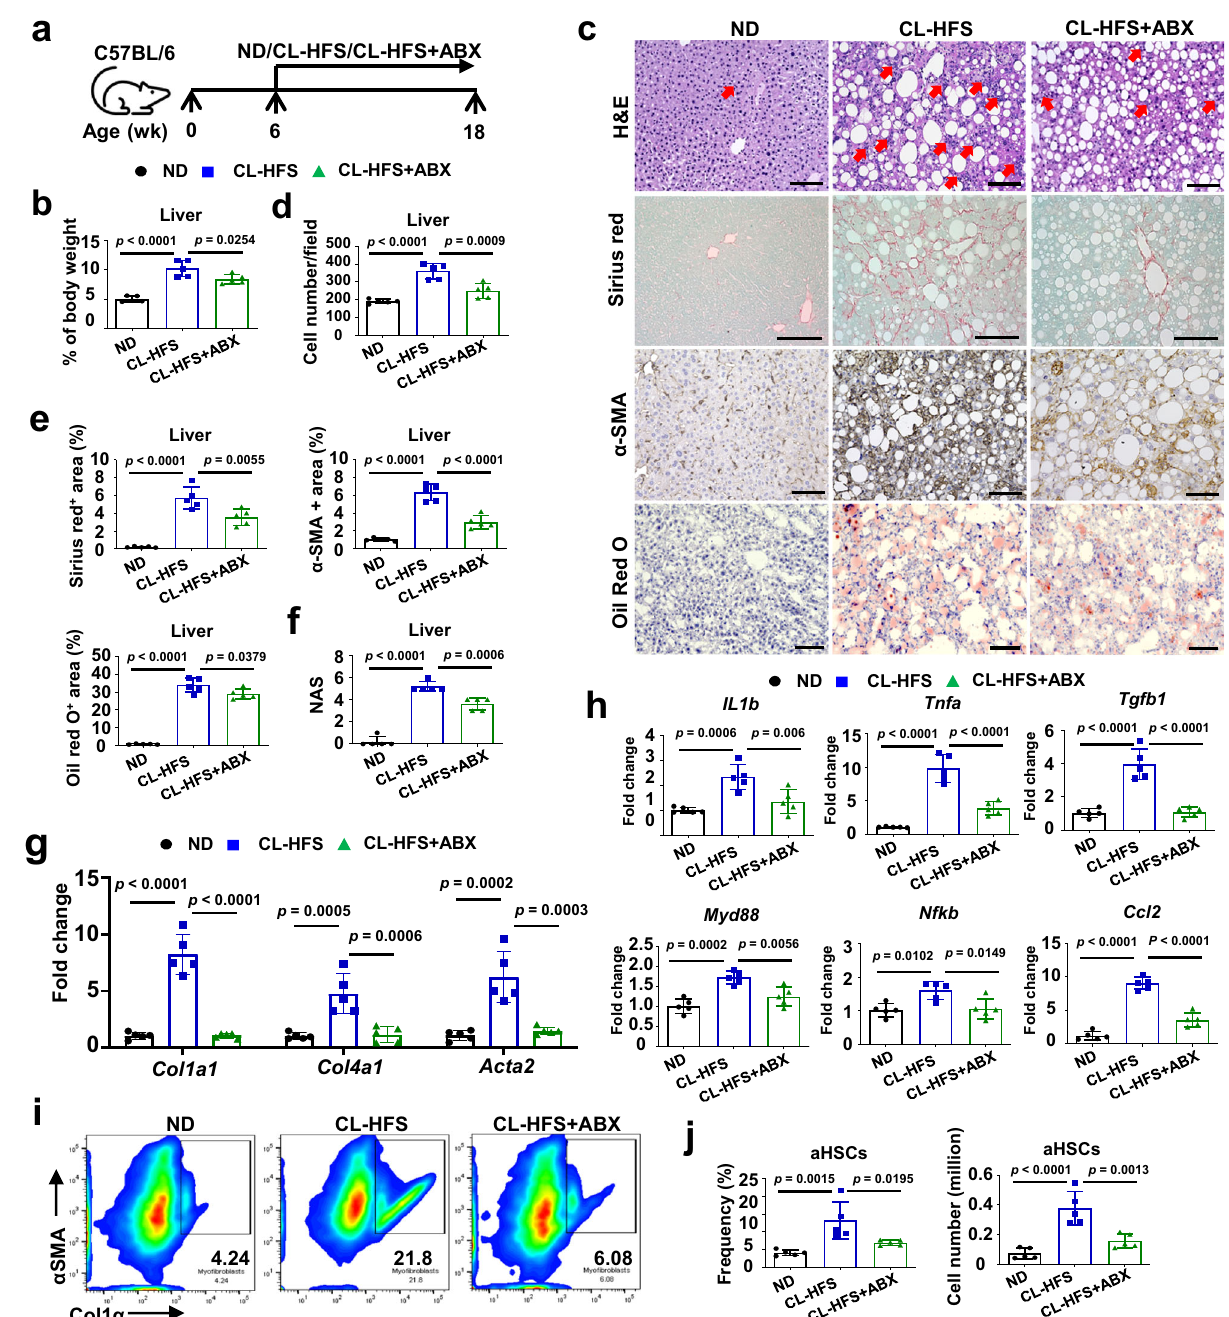
Fig. 2 | ABX treatment slows the development of CL-HFS-induced NASH. a An outline depicting ABX treatment design. Six-week-old WT C57BL/6J mice were fed with a CL-HFS for 12 weeks with or without simultaneous ABX treatment, then euthanized for the following studies. ND-fed mice were used for controls. b Effect of ABXonCL-HFS-inducedincreaseintheratiosofliver-to-bodyweight.Compared to ND, CL-HFS caused an increase in the liver-to-bodyweight ratio which was sup- pressedbyABXtreatment. c EffectofABXonCL-HFS-inducedNASH.Comparedto untreated mice, ABX treatment led to an obvious reduction in the liver in fi ltration ofin fl ammatorycells(redarrow)(H&Estaining),productionofcollagen(Siriusred staining), α -SMA(IHCdetection), and lipidaccumulation (Oilred O staining) in CL- HFS-fedmice. Bar:100 μ m. d Semi-quanti fi cation of in fl ammatorycellsin fi ltratiing into the liver; e Semi-quanti fi cation of collagen production, α -SMA protein expression,andlipidaccumulationintheliversofthreegroupsofmiceshownin c .